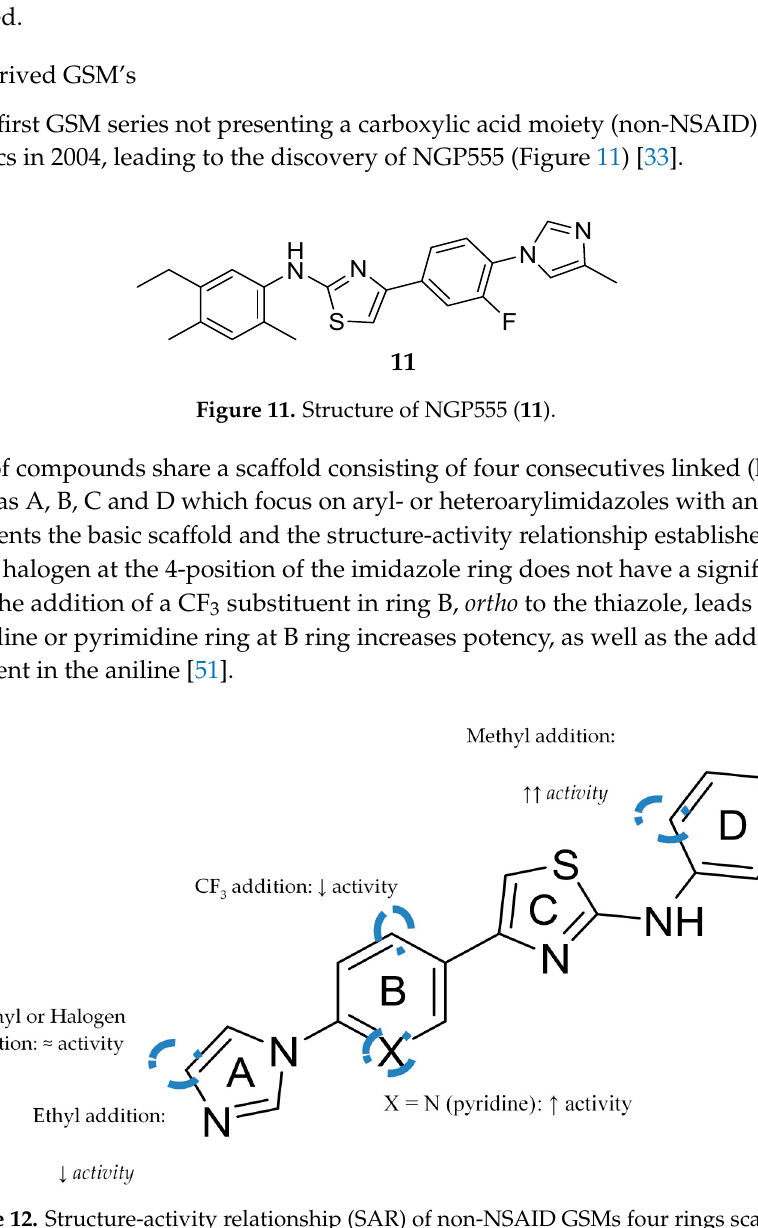
Figure 12. Structure-activity relationship (SAR) of non-NSAID GSMs four rings scaffold.